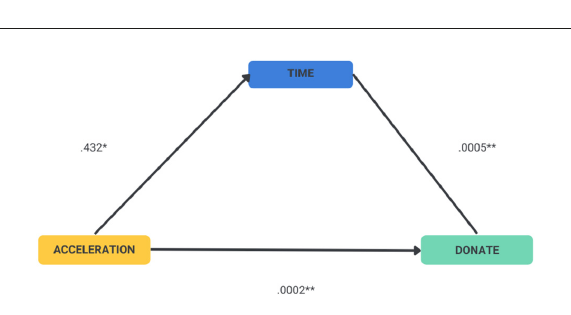
FIGURE6 Estimation of the direct effect of Acceleration on donations and the mediating effect of Acceleration on time to watch videos. * p < 0.05, ** p <